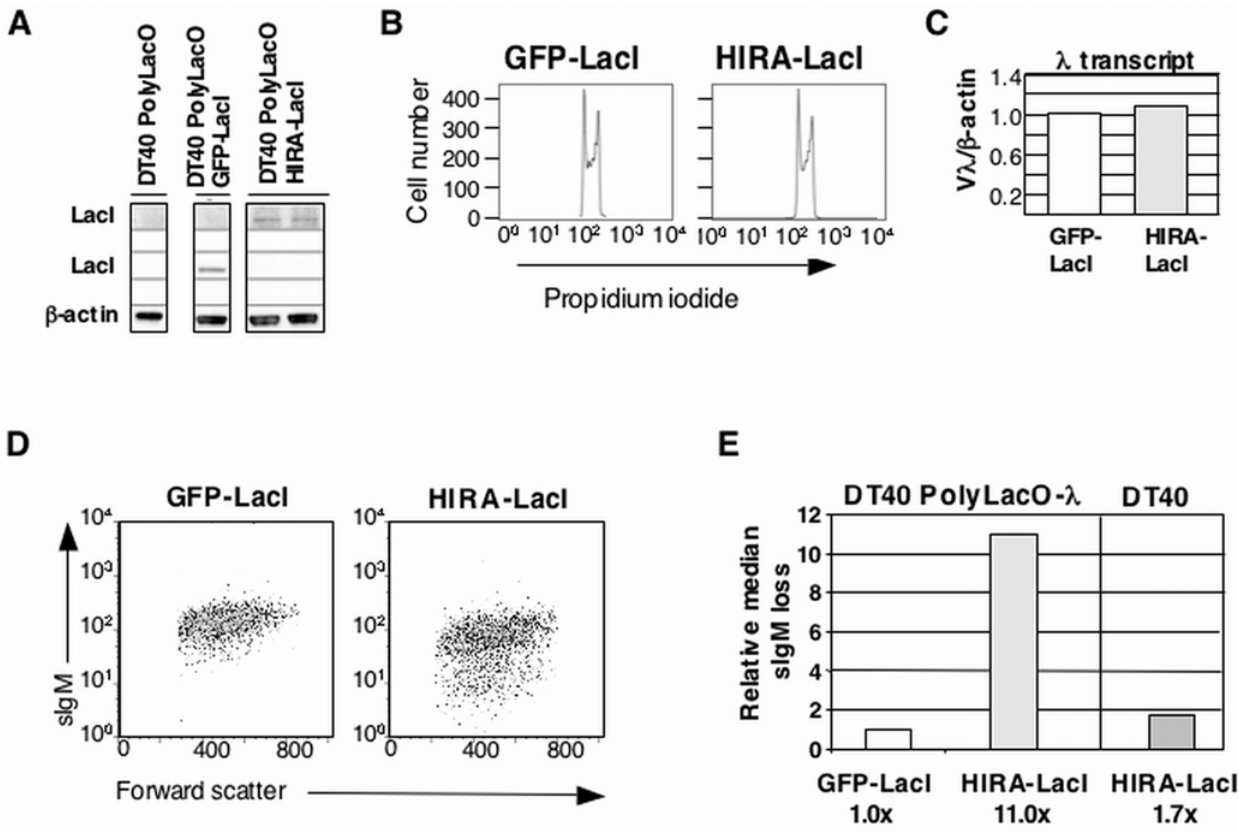
Figure 4. Tethered HIRA Accelerates Ig Gene Diversification. (A) Western blot analysis of expression of GFP-LacI or HIRA-LacI in indicated transfectants. Two individual clones are shown for HIRA-LacI expression. Assay was performed by blotting with anti-LacI antibodies (for detection of GFP-LacI and HIRA-LacI), relative to b -actin control. (B) Cell cycle profile of DT40 PolyLacO- l GFP-LacI and DT40 PolyLacO- l HIRA-LacI transfectants. (C) Quantitation of RT-PCR comparison of V l transcript levels in DT40 PolyLacO- l GFP-LacI and DT40 PolyLacO- l HIRA-LacI transfectants. Values represent the average of at least 2 amplifications that were normalized to the average value for DT40 PolyLacO- l GFP-LacI. (D) Flow cytometry of individual expanded clones in representative populations of DT40 PolyLacO- l GFP-LacI and DT40 PolyLacO- l HIRA-LacI transfectants, stained with anti-IgM. (E) Median sIgM loss in panels of independent DT40 PolyLacO- l HIRA-LacI (n=48), and DT40 HIRA transfectants (n=24), normalized to DT40 PolyLacO- l GFP-LacI transfectants (n=24). The figure shows combined data from at least two independent transfectants for each construct. The fold increase relative to control DT40 PolyLacO- l GFP-LacI transfectants is shown below.